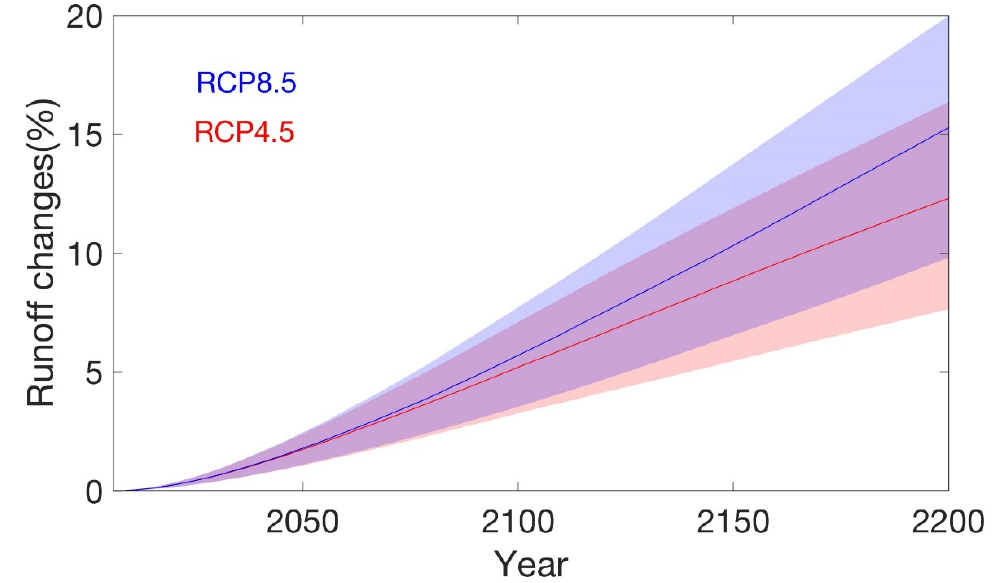
Figure 11. Percentage of runoff changes caused by runoff-elevation feedback by the average of two DD methods under RCP4.5 (red) and RCP8.5 (blue) scenarios. Colored shading indicates the spread from different DDFs .